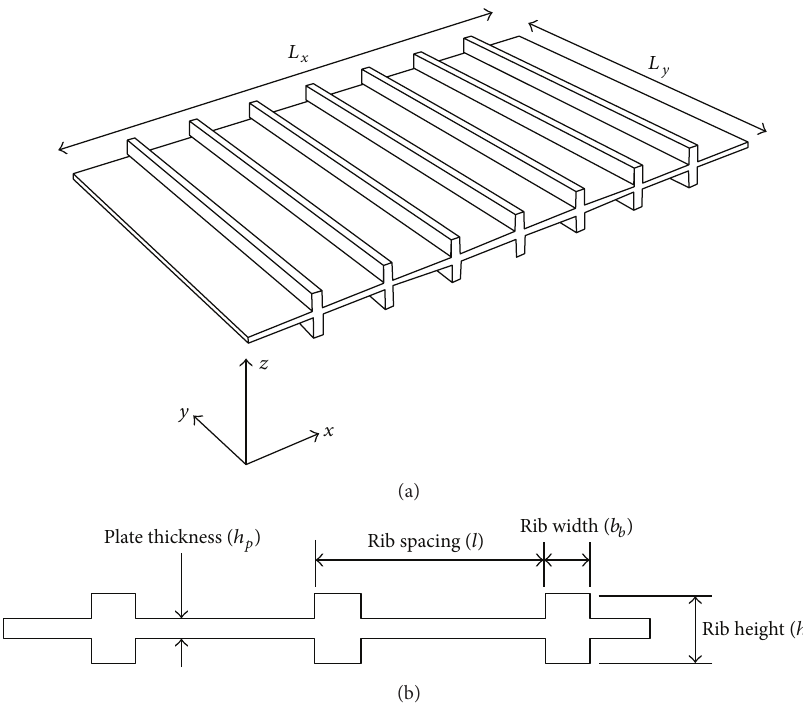
Figure 2: Periodic ribbed plate (a) main dimensions and (b) periodic plate